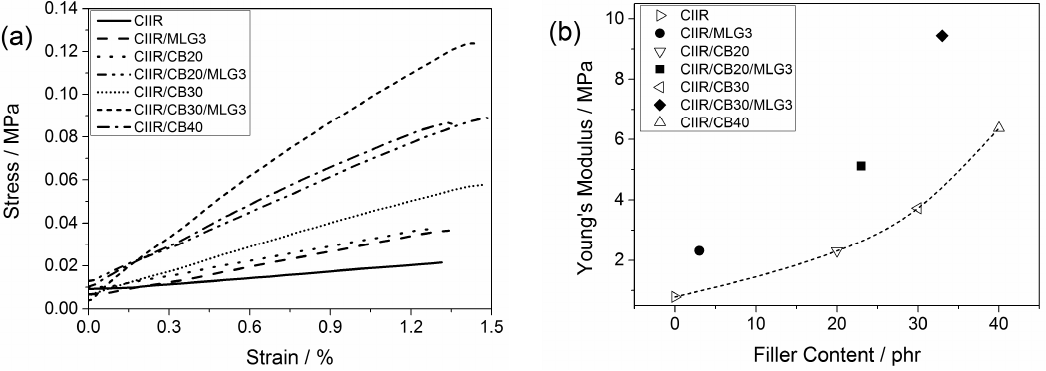
Figure 10. ( a ) Stress vs. strain curves to determine Young’s modulus of CIIR and its composites; and ( b ) Young’s modulus as a function of the filler content. The line is a visual guide.